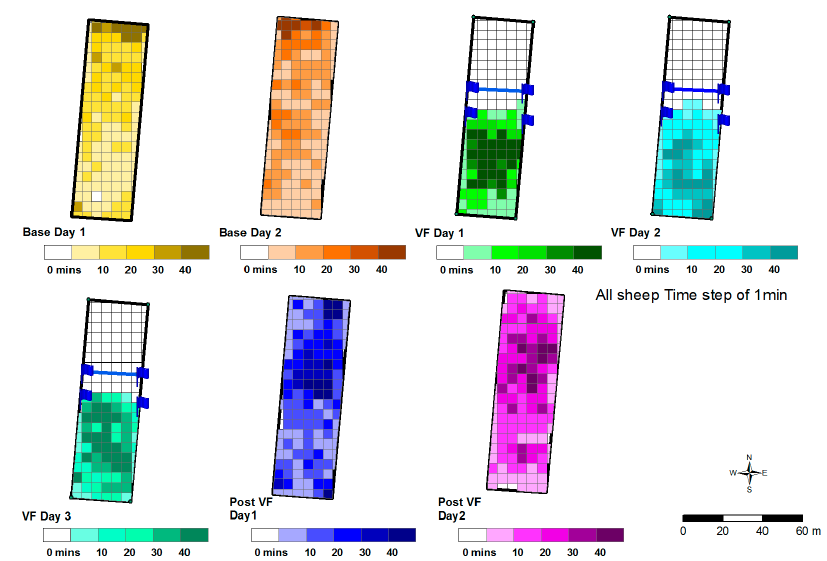
Figure 4. GPS tracking of the six sheep’s use of the paddock throughout the trial. Base Day 1 and 2 is prior to the virtual fence application (Pre VF), VF day 1 to 3 is during the application of the virtual fence and Post VF day 1 and 2 is after the fences removal. The flags with no line between them indicate the start of the warning zone. The flags joined with a line indicate the start of the exclusion zone.